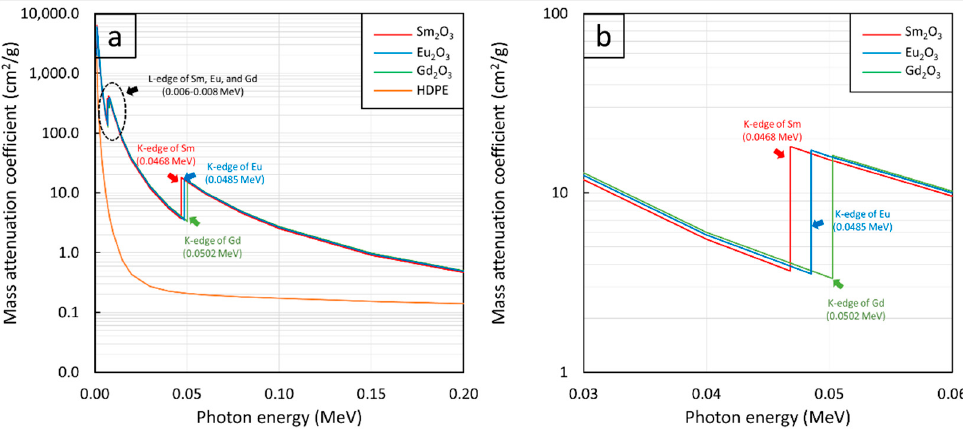
Figure 2. μ m values of Sm 2 O 3 , Eu 2 O 3 , Gd 2 O 3 , and HDPE showing K ‐ edge and L ‐ edge behaviors of Sm, Eu, and Gd at photon energies of ( a ) 0.001–0.2 MeV and ( b ) 0.03–0.06 MeV. The μ m values for the Sm 2 O 3 /HDPE, Eu 2 O 3 /HDPE, and Gd 2 O 3 /HDPE composites with filler contents of 0–60 wt.%, determined at the photon energies of 0.1, 0.5, 1, and 5 MeV,